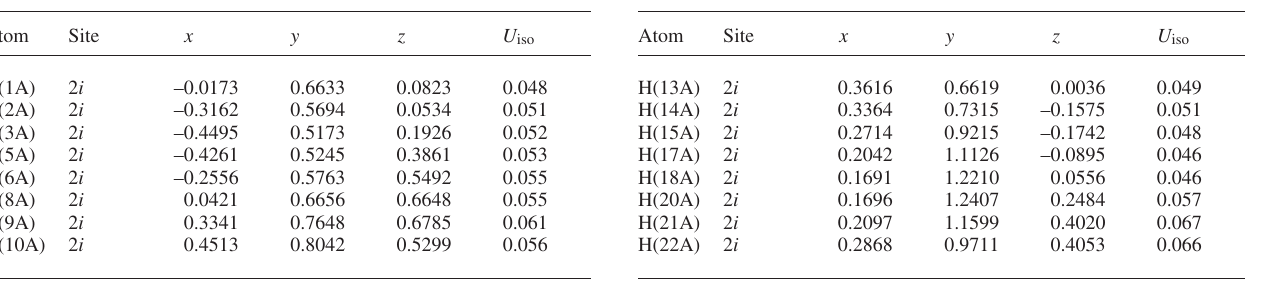
Table 2. Atomic coordinates and displacement parameters (in Å 2 )